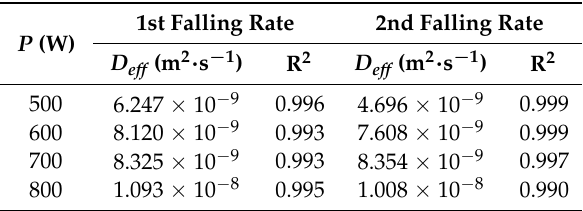
Table 7. Effective diffusion coefficient of lignite at different microwave power levels during microwave drying.